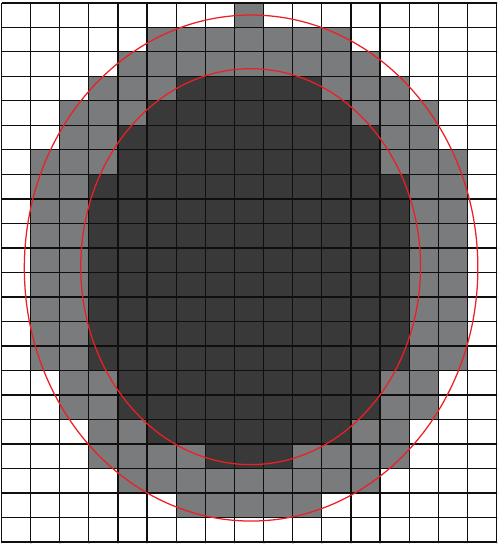
Figure 3: 0.5-approximation set of an interval